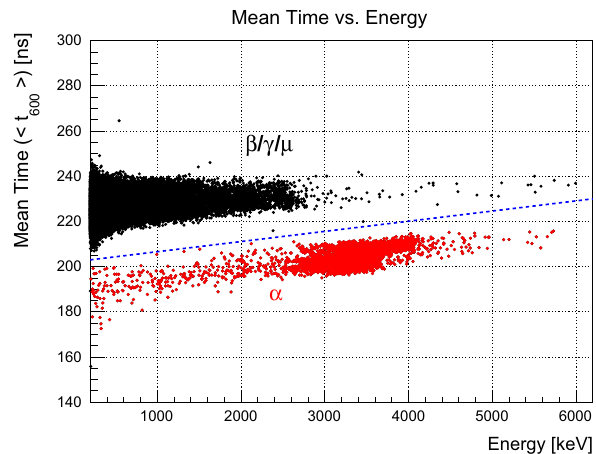
Fig. 3 NaI-33 calibration spectrum with 241 Am source. The gaussian fit to the 59.5keV peak is shown in red